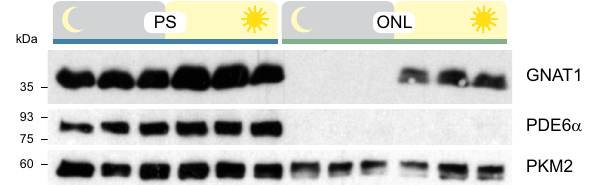
Figure 3. Light-induced translocation of transducin in photoreceptors. Western blot analysis showing the distribution of the α -subunit of rod transducin (GNAT1) in the photoreceptor segments (PS) and outer nuclear layer (ONL) of dark- (left) and light- (right) adapted mice. PDE6 α located exclusively in PS samples was used as a control for layer separation and PKM2 as a loading control.